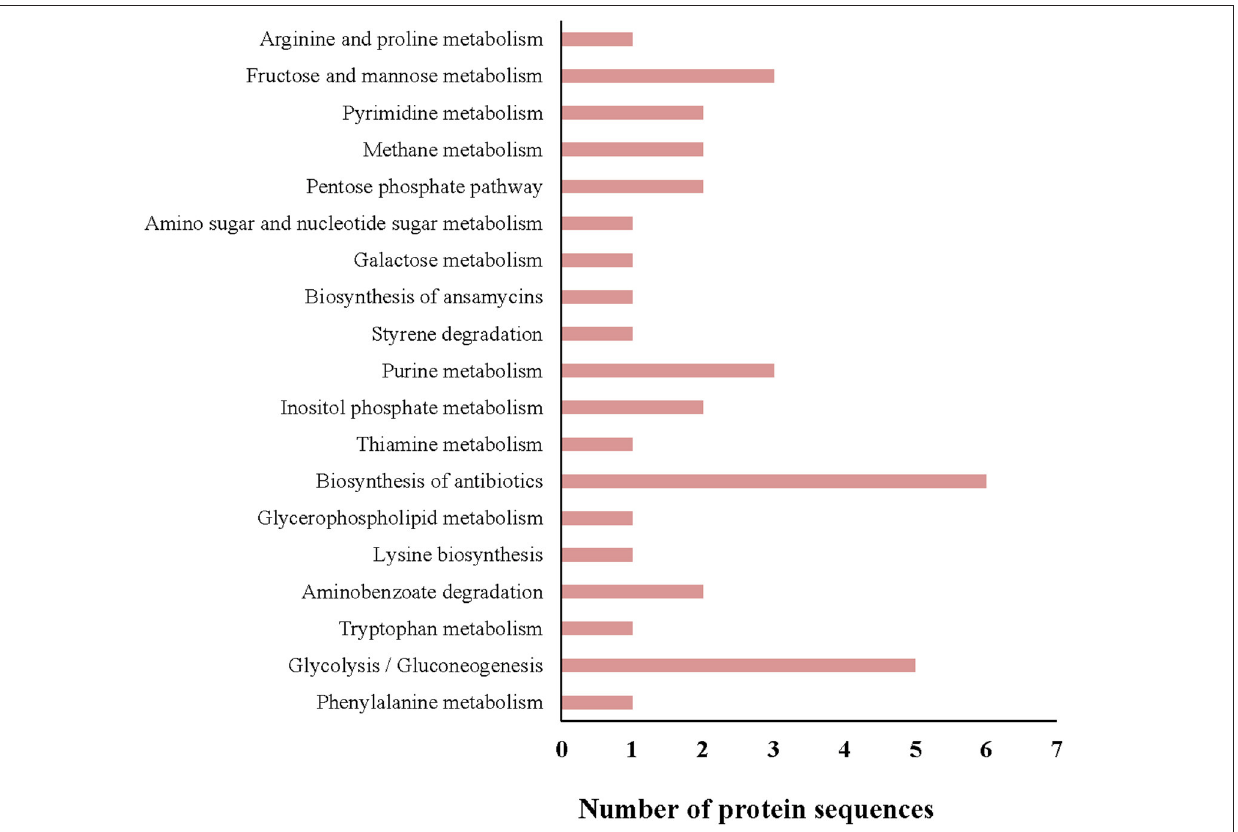
FIGURE 3 | KEGG pathway analysis of the G. adiacens secretome. All protein sequences from the secretome were analyzed by KEGG pathway tool, which was included as a “plugin” tool within Blast2GO software.